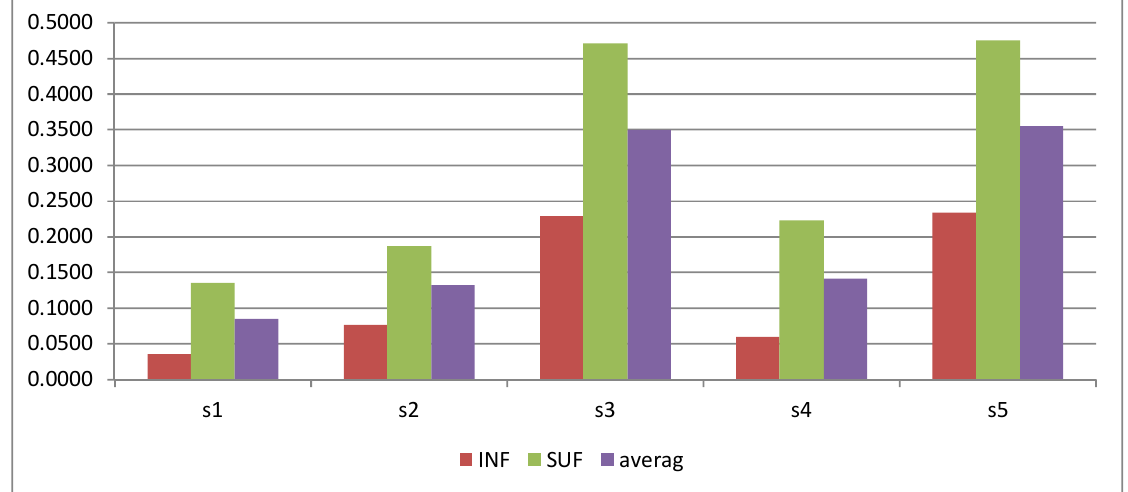
Fig.1. Normalized technical importance ratings of the five